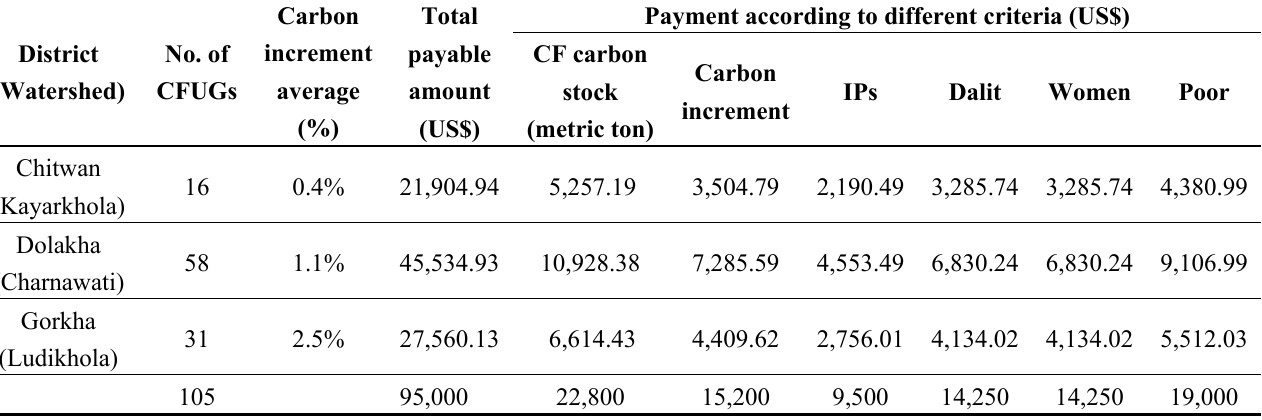
Table 3. Overview of first